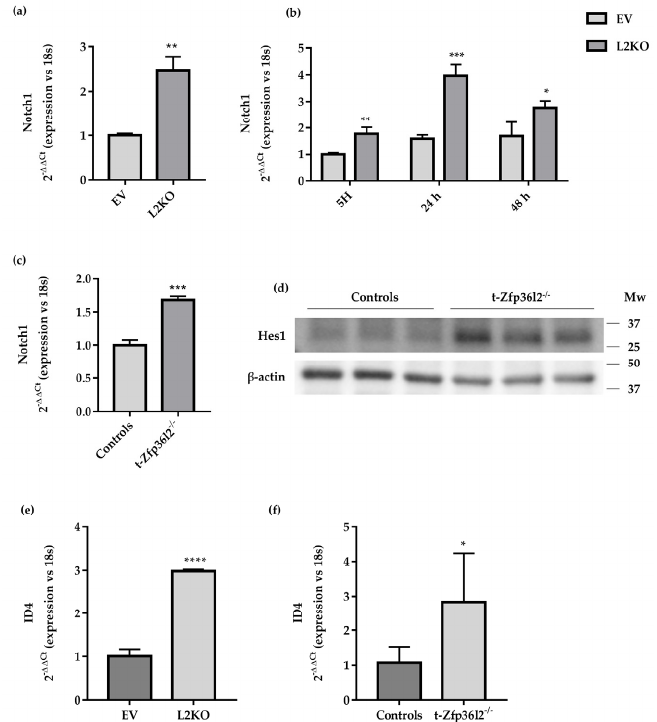
Figure 8. Modulation of Notch1 pathways in t- Zfp36l2 -/- mice and L2KO cells. ( a ) RTqPCR analysis of Notch1 expression in L2KO and EV cells and ( b ) RTqPCR analysis of Notch1 expression and its modulation by TSH signaling in L2KO and EV cells; 5H, cell culture medium deprived from TSH; 24 h and 48 h, time points of TSH signalling induction using complete cell culture medium. ( c ) RTqPCR analysis of Notch1 expression in thyroid extracts from t − Zfp36l2 -/- ( n = 3) and control ( n = 3) mice. ( d ) Western blotting analysis of HES1 in extracts from thyroid samples of t − Zfp36l2 -/- ( n = 3) and control mice ( n = 3). ( e ) RTqPCR analysis of Id4 mRNA in L2KO and EV cells, ( f ) thyroid extracts from t − Zfp36l2 -/- ( n = 3) and control ( n = 3) mice. RTqPCR data are reported as mean ± standard deviation of ∆∆ Ct values (FC values of gene normalized vs. FC values of 18SrRNA to obtain ∆ Ct values of samples; ∆ Ct values of KO samples are normalized vs. ∆ Ct of control samples to obtain ∆∆ Ct values) in KO ( n = 3) and controls ( n = 3); * p < 0.05; **p< 0.01; ***p<0.001; **** p < 0.0001.